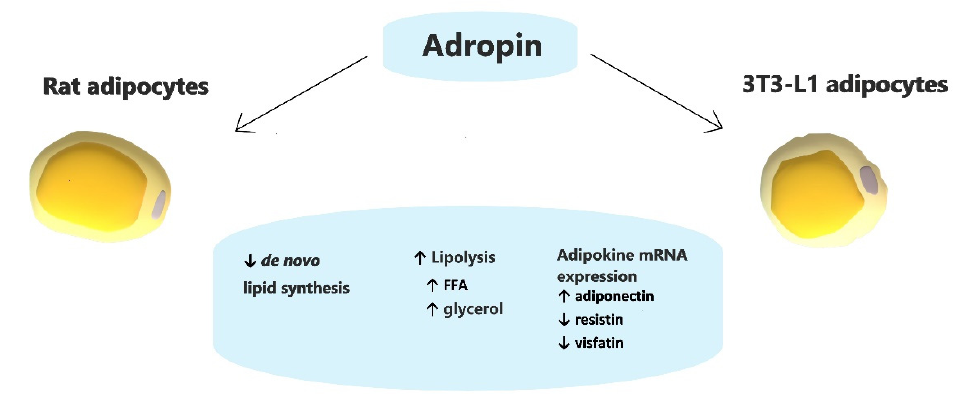
Figure 6. Schematic summary of the effects of adropin on white rodent adipocytes.